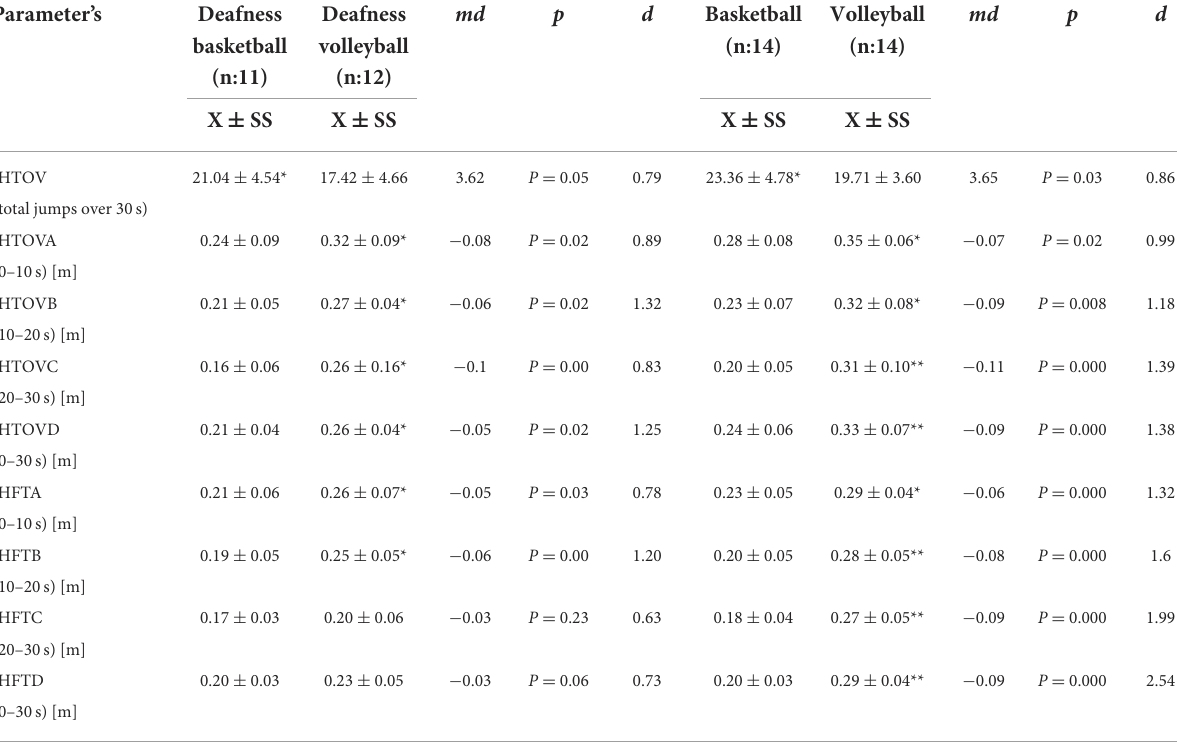
TABLE 4 Comparison of jump height from take off velocity and jump height from flight time of deaf basketball/volleyball and non-deaf basketball/volleyball players.